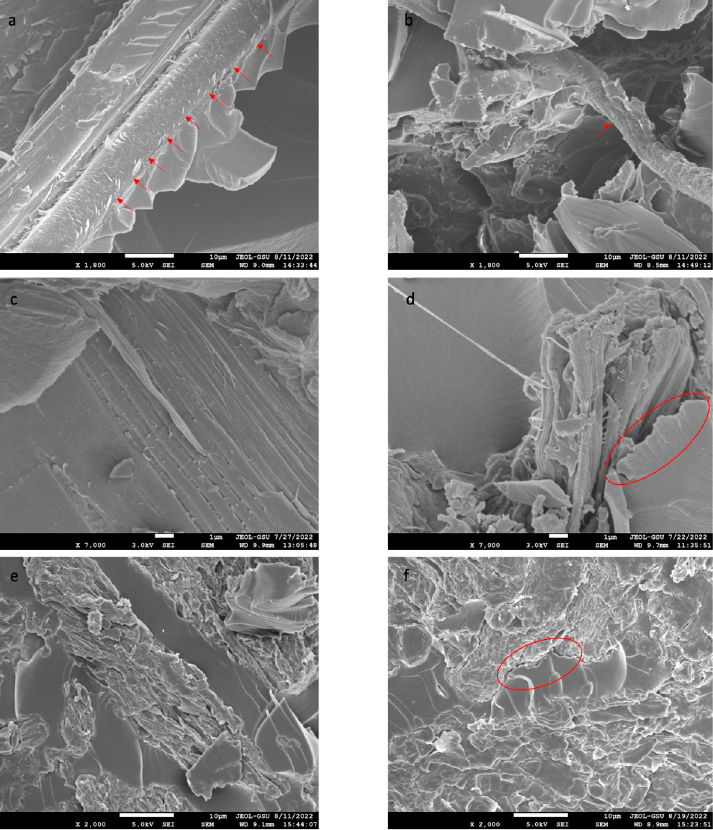
Figure 8. SEM images of ( a ) MIS150ITA (arrows indicate Polymer residue along reinforcement fiber); ( b ) MIS150 (arrow indicates na exposed fiber); ( c ) PIN150ITA; ( d ) PIN150 (gap between matrix and reinforcement circled); ( e ) ALG150ITA; ( f ) ALG150 (gap between matrix and reinforcement circled).